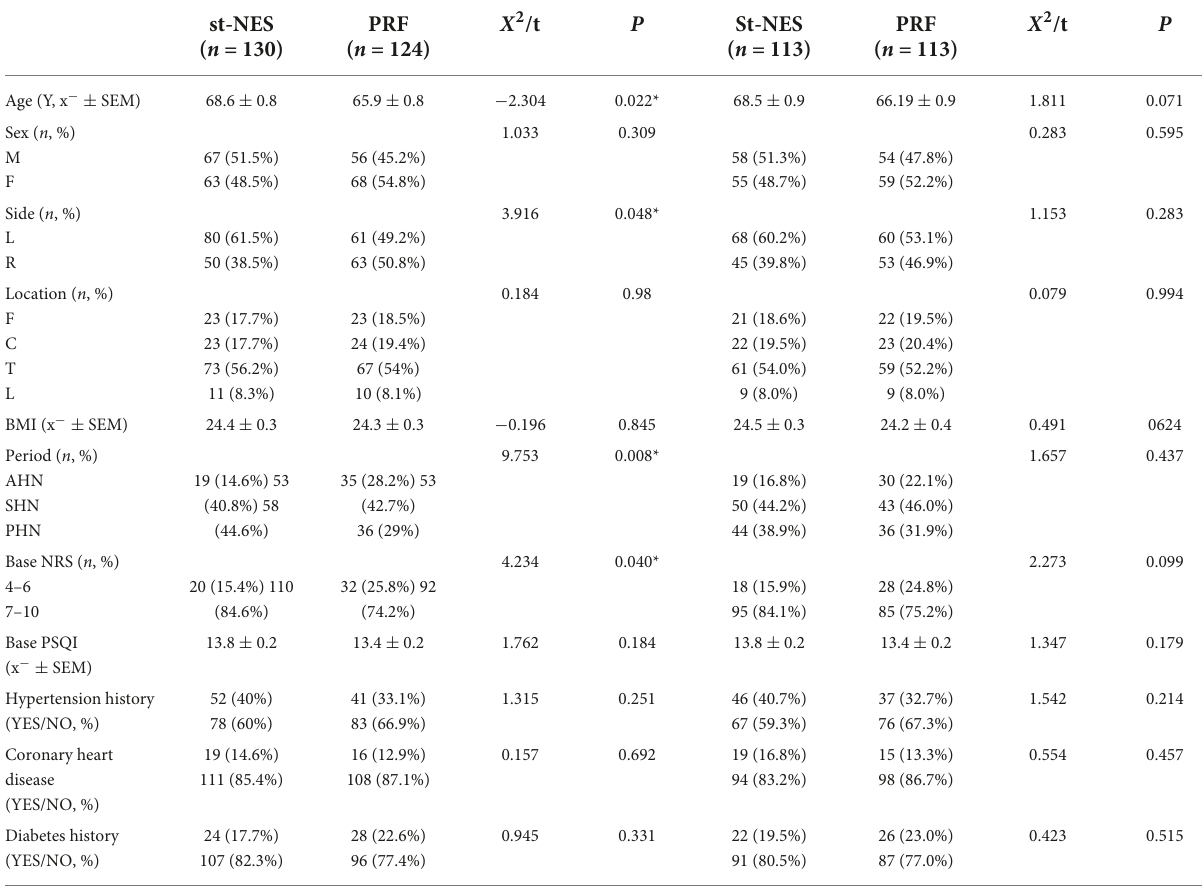
TABLE 1 Patients’